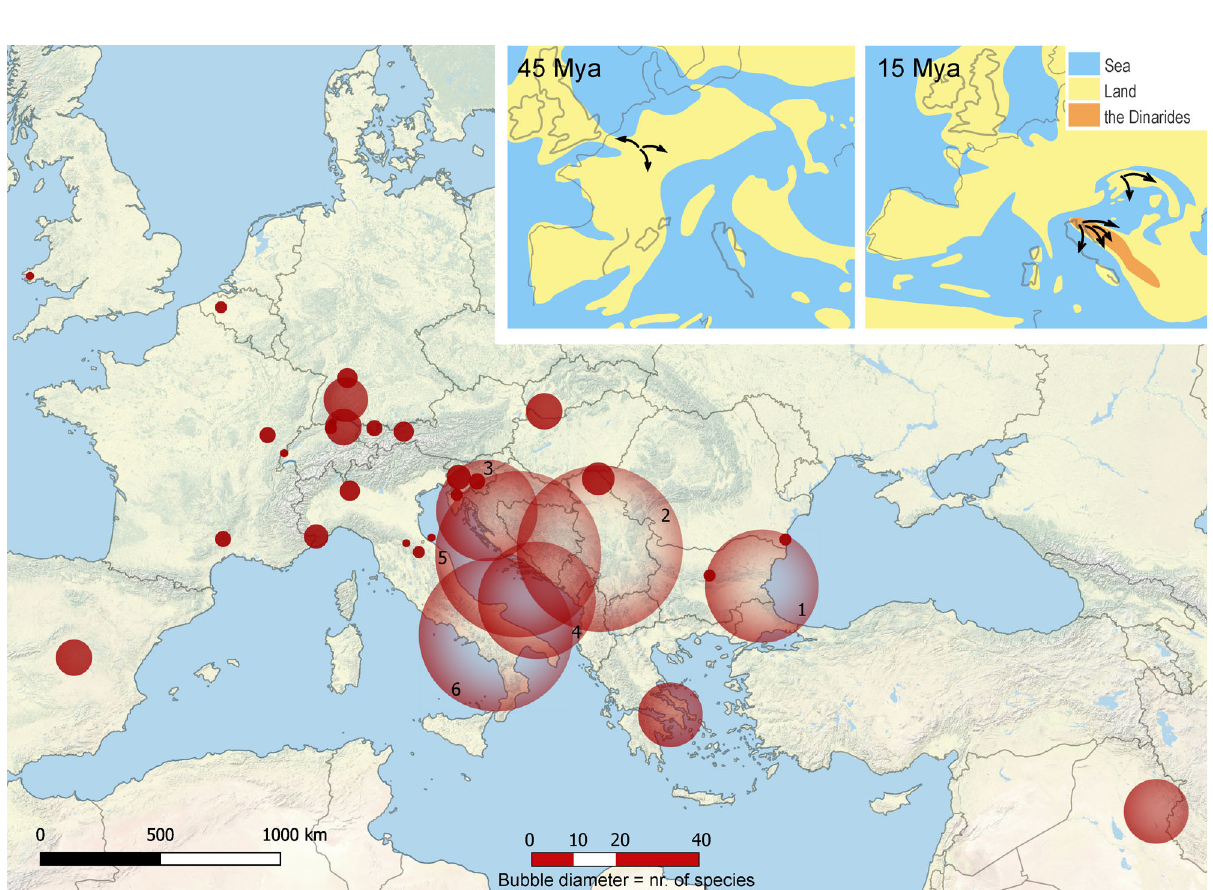
Fig. 3 Geographical extent of the adaptive radiation of Niphargus . Bubbles represent the geographic position of subclades; their size re fl ects species numbers. Clades are numbered as follows: 1. Pontic, 2. Pannonian, 3. North Dinaric, 4. South Dinaric, 5. West Balkan and 6. Apennine clade. Inset: Phylogeny-based reconstruction of ancestral areas and directions of colonisation at 45 and 15 Mya, plotted on corresponding paleo maps, adapted after 39,40 . The geographic origin of species-rich subclades that arose through adaptive radiation corresponds to emerging karstic regions in South-Eastern Europe at about 15 Mya. The contemporary map was produced using QGIS 77 and Esri World Physical Map 78